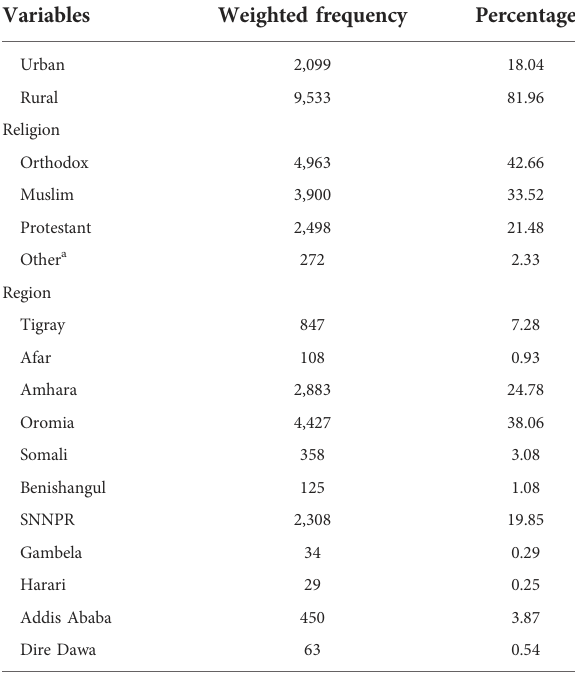
TABLE 1 Basic characteristics of ever-married reproductive-age Women in